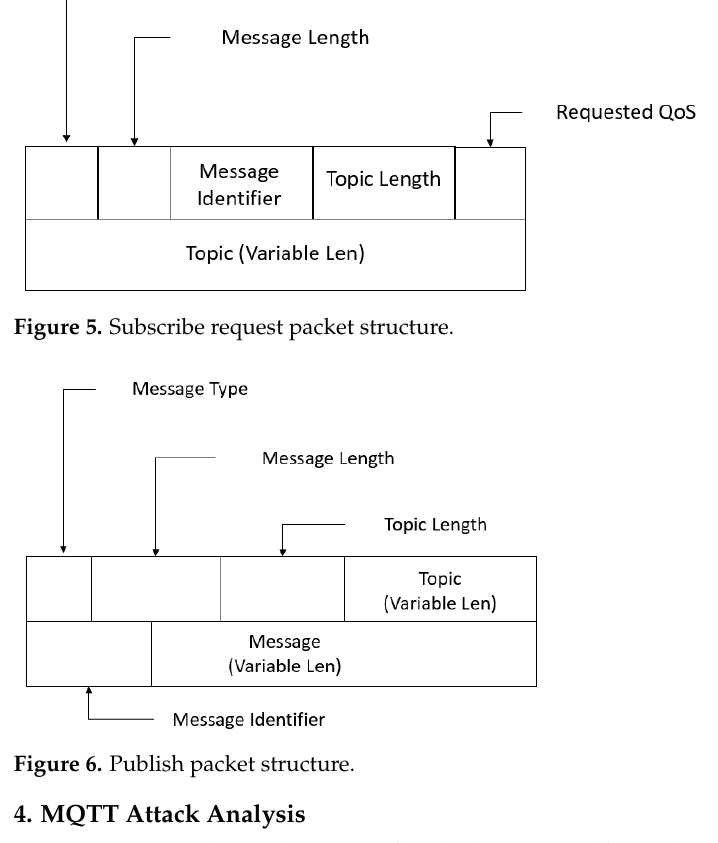
Figure 6. Publish packet structure.